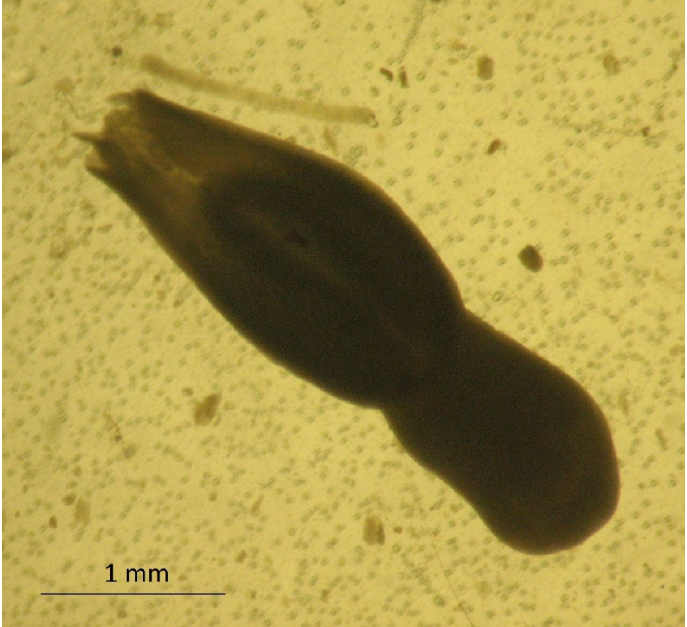
Figure 1. The adult stage of A. alata isolated from the small intestine of a red fox; 40× magnification (by J. Karamon).